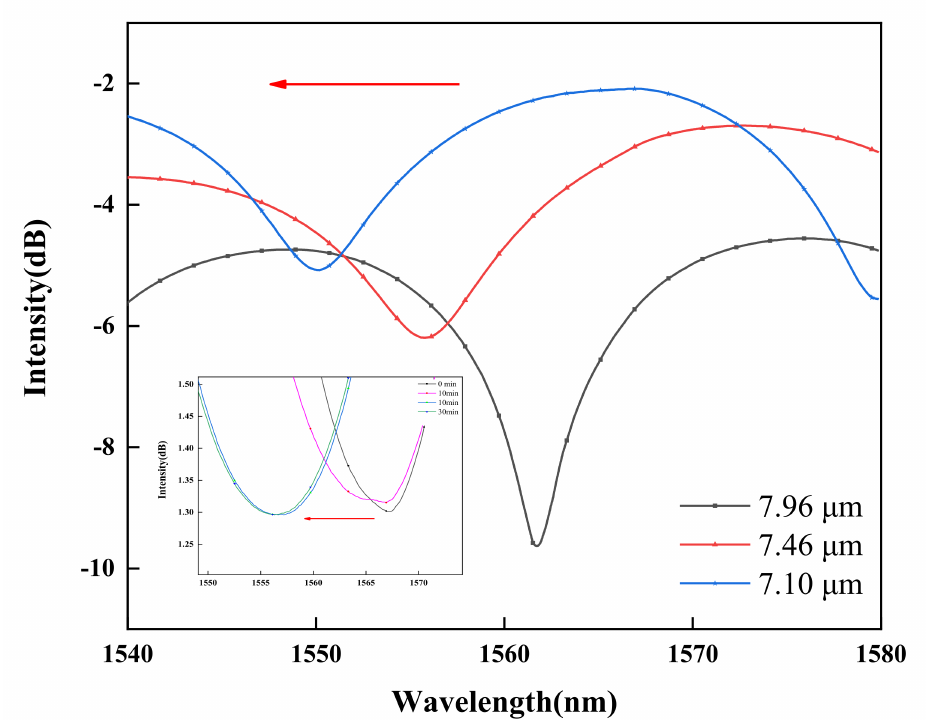
Figure 8. The movement of the interference spectrum peak for different film thicknesses and curing time at the same pressure.